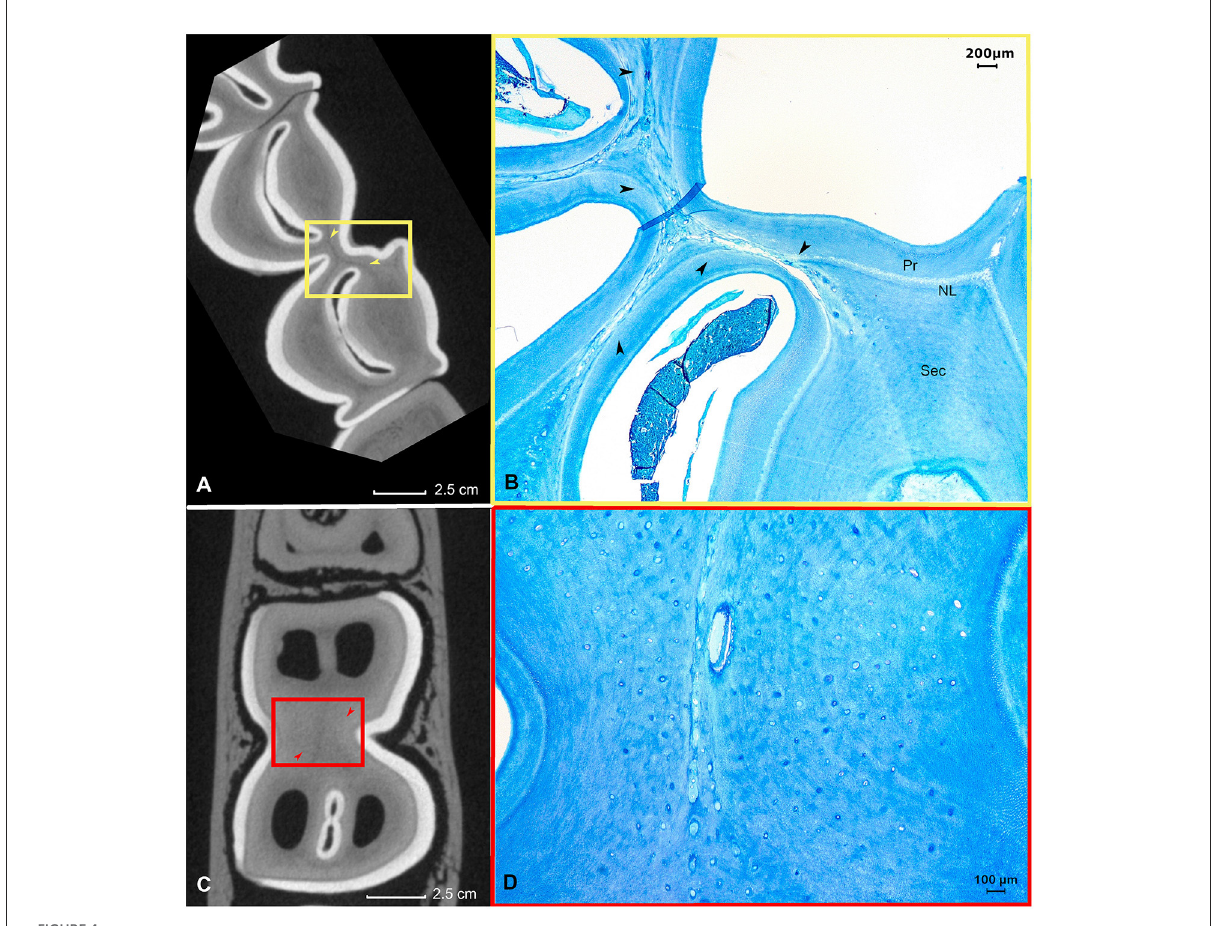
FIGURE4 The histological appearance of vasodentin in a first molar in the left lower jaw in an alpaca of 3 years old (Dental age 2 years and 4 months). (A) µ -CT image of a sub-occlusal section at 4mm depth. Note the dark gray lines indicating a “different type” of dentin (yellow arrows). A yellow box allows the orientation of the accompanying histological image (B) . (B) Histological appearance of the dentinal tissue at the level of the connection between the mesial and distal column (origin yellow box 4A). The dentin in this region is intermingled with remnants of blood vessels. This specific dental tissue was classified as vasodentin. Pr: primary dentin, NL: neonatal line, Sec: Secondary dentin (Toluidin, 2.5x magnification). (C) µ -CT image of a mid-tooth section at 10mm depth. Note the dark gray region indicating a ‘different type’ of dentin (red arrows). (D) Histological appearance of the magnified dentinal tissue at the center of the tooth. The dentin in this region is intermingled with remnants of blood vessels (Toluidin, 5x